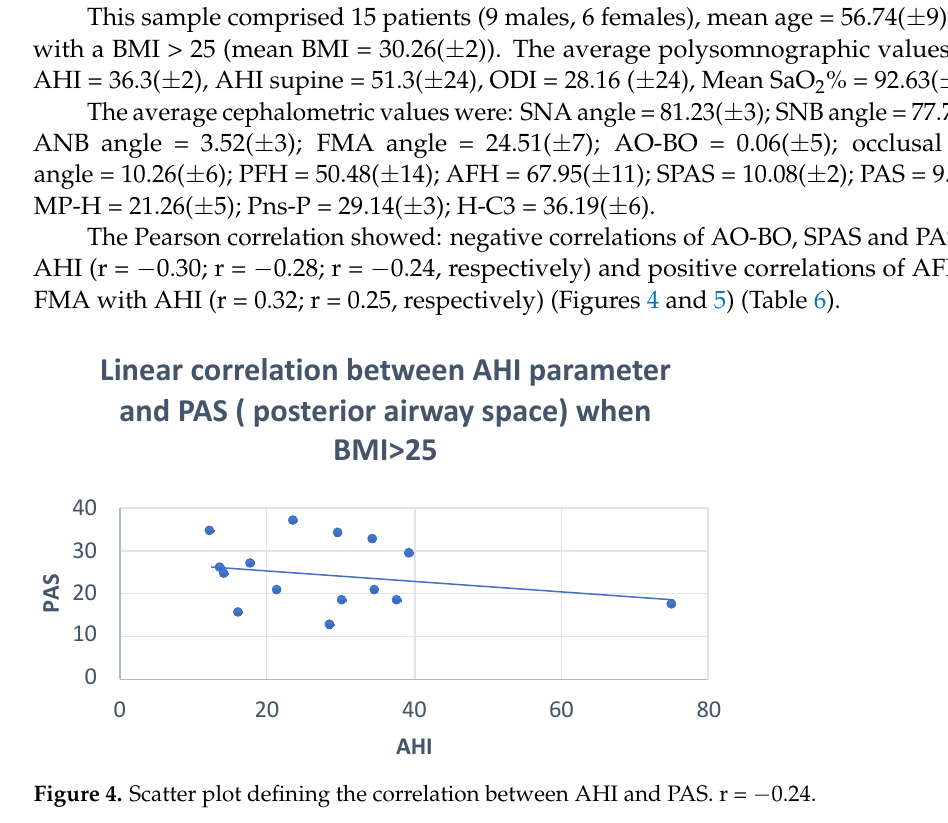
Figure 5. Scatter plot defining the correlation between AHI and SPAS. r = − 0.28. Table 6. Pearson correlation analysis between cephalometric variables and OSA parameters (AHI, AHI supine) in overweight group (BMI > 25).